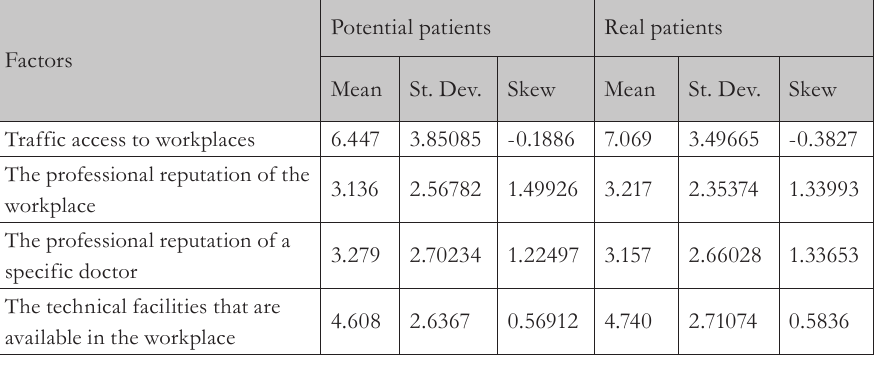
Tab. 6 – Group statistics description (Source: own